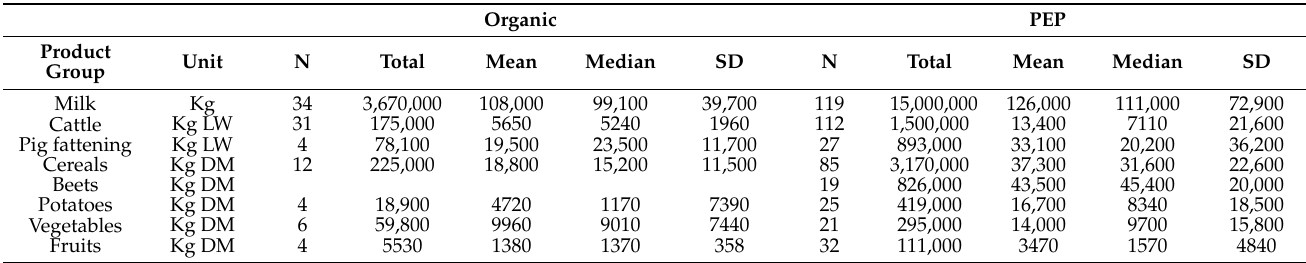
Table A3. Amount of product groups by farming system (LW = live weight, DM = dry matter, PEP = Proof of Ecological Performance). Groups with N in parenthesis were not used in the analysis.